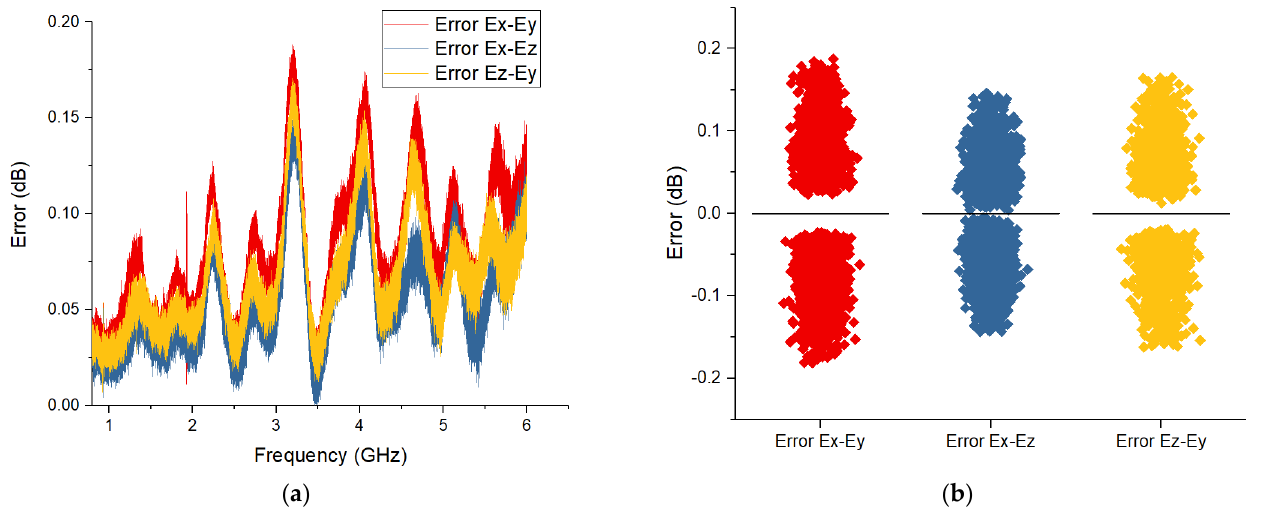
Figure 9. ( a ) Estimation of the error due to mutual coupling effect vs. frequency for all sensor elements. ( b ) Error variation boxplots.